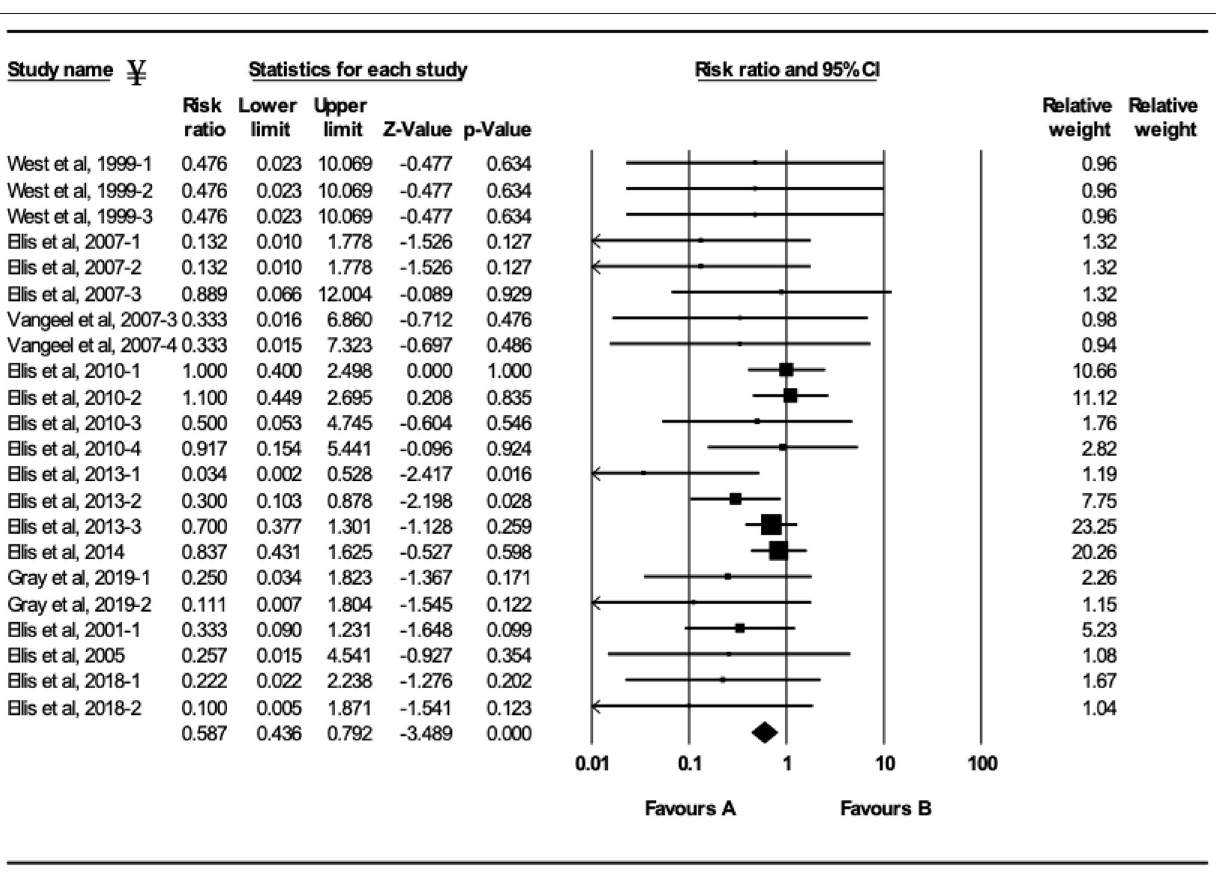
FIGURE 2 | Forest plot of mortality risk ratios from experimental BRSV challenge trials that evaluated MLV and inactivated BRSV vaccines. U Only trials with a significant mortality effect between vaccinated and control calves are shown by the meta-analysis software in the forest plot. Heterogeneity stats: Q -Value: 18.64, df ( Q ): 21 p : 0.61 I 2 :